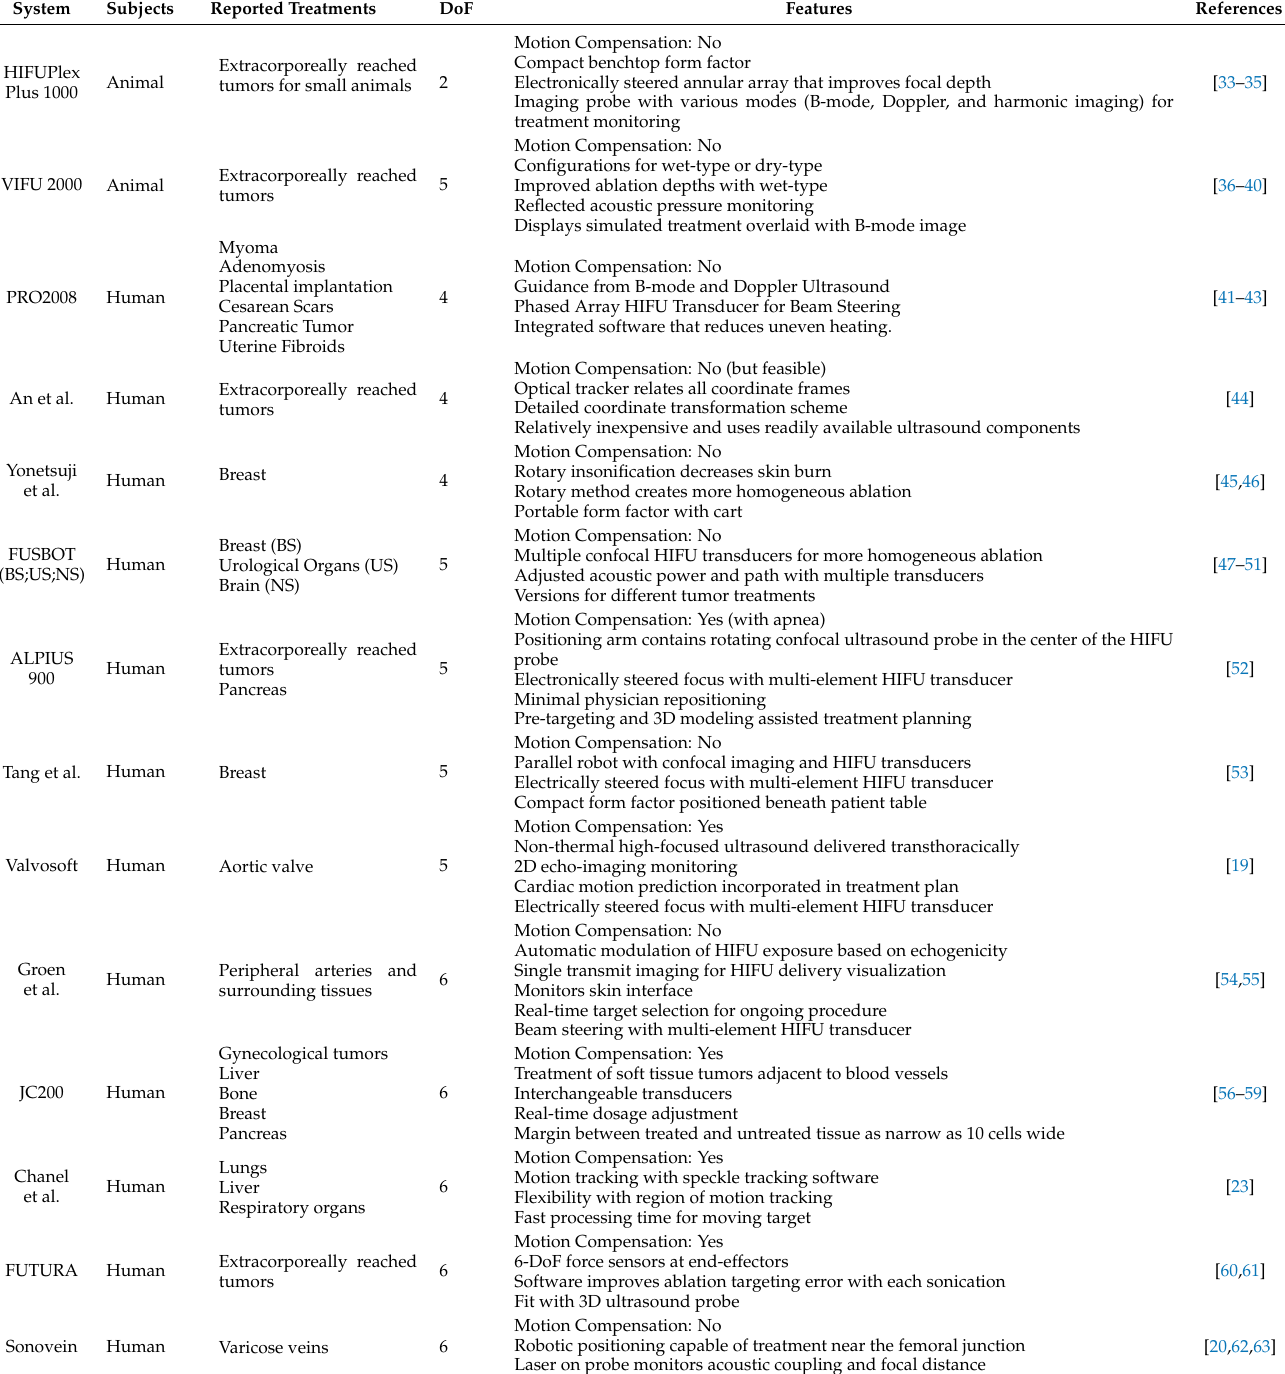
Table 1. Overview of Ultrasound-guided HIFU